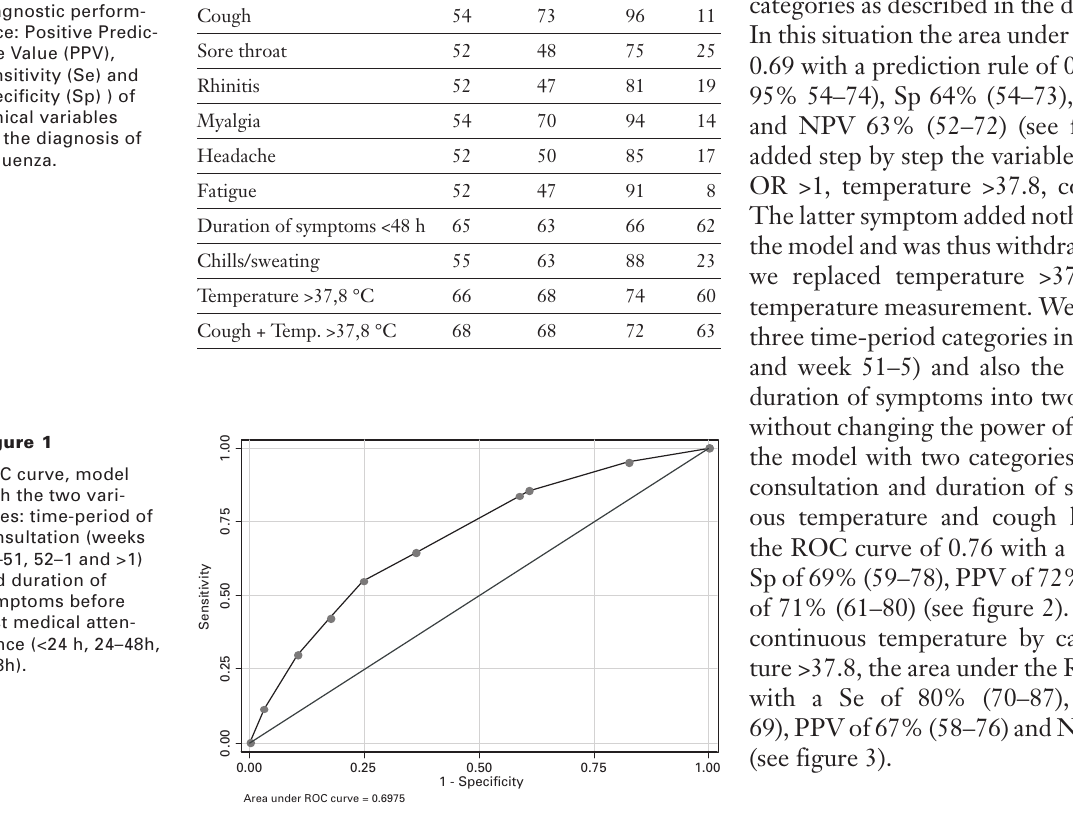
Diagnostic perform- ance: Positive Predic- tive Value (PPV), sensitivity (Se) and specificity (Sp) ) of clinical variables for the diagnosis of influenza.